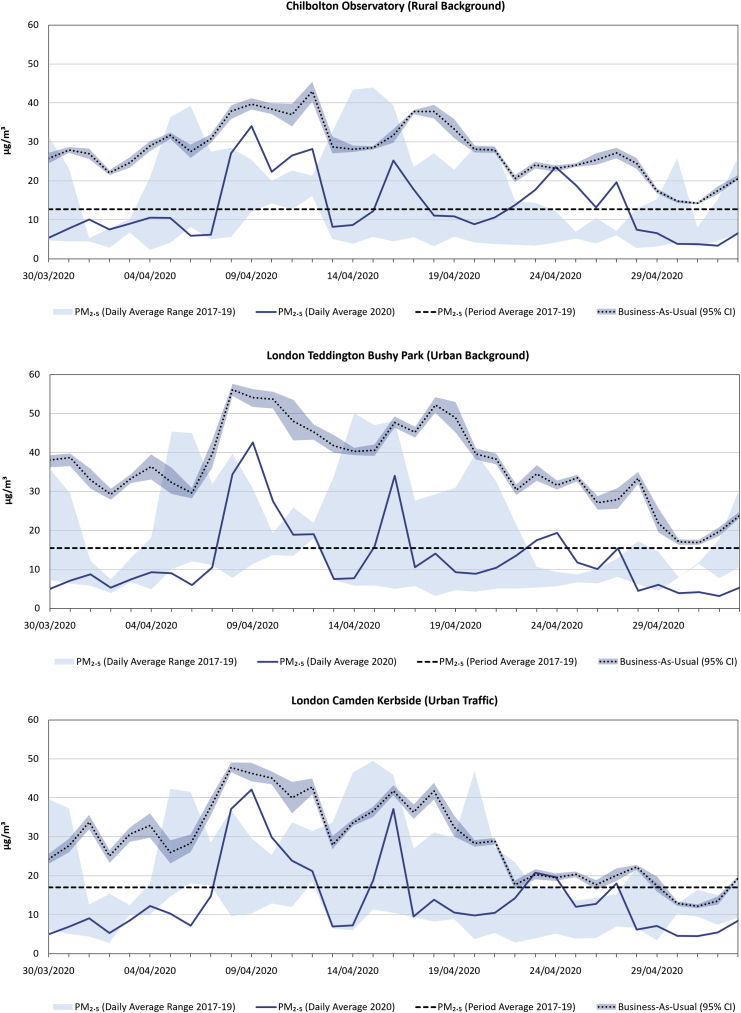
Time-series plots of measured daily-average PM2.5 concentrations for weeks 14–18 of 2020, in relation to the range of measurements for corresponding weekdays in 2017–19, and estimates under a business-as-usual (BUA) scenario.